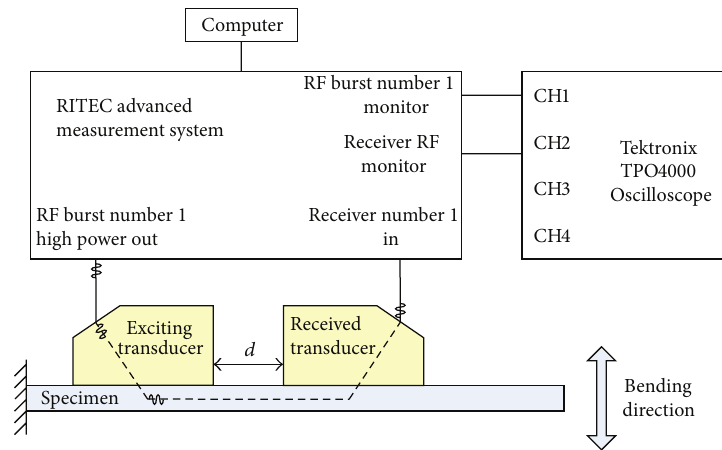
Figure 4: Block diagram of ultrasonic nonlinear testing system.